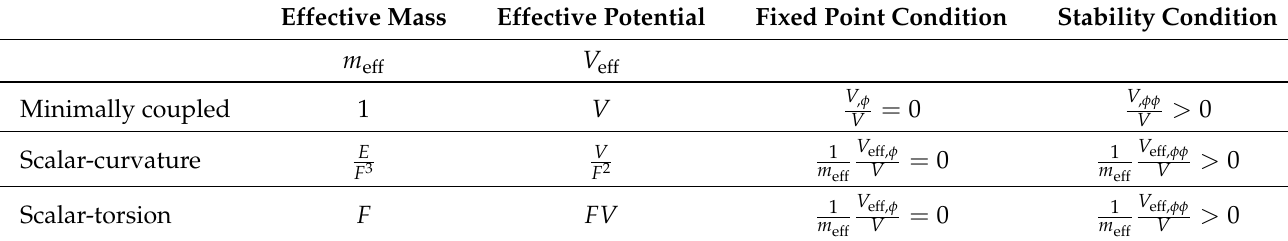
Table 1. Mechanical analogue quantities of the scalar field cosmological equation in the case of minimal coupling (15), nonminimal coupling to curvature (13), and nonminimal coupling to torsion (14). The conditions for the fixed points and their stability were deduced in Reference [76] for the scalar-curvature case and follow from Eqations (27) and (28) in the scalar-torsion